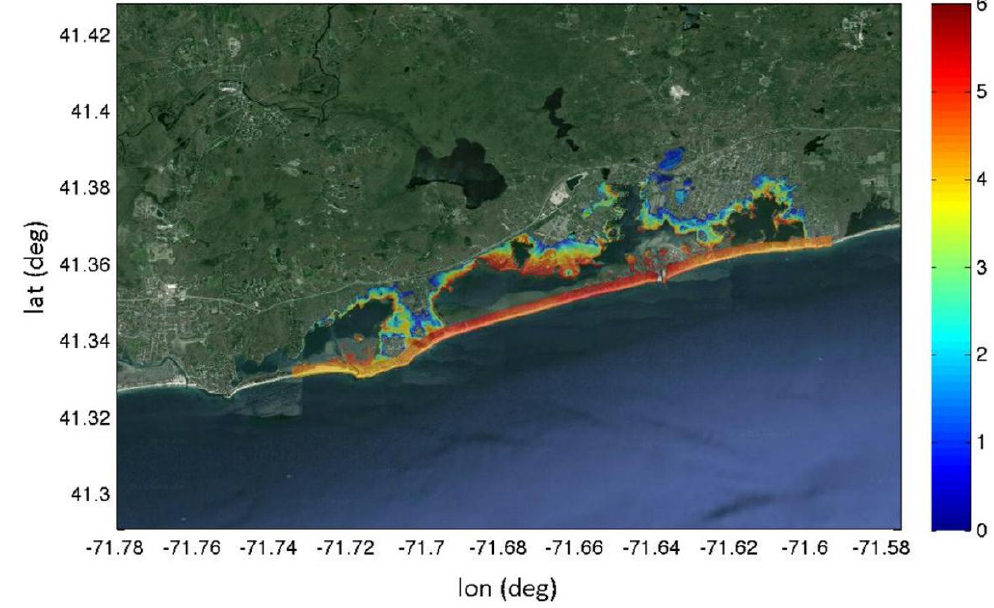
Figure 11. Total water depth (m) (inundation plus wave height) for Charlestown, RI, 100 year event, dune eroded [20]. The contour scale provided at the right of the figure is in meters.